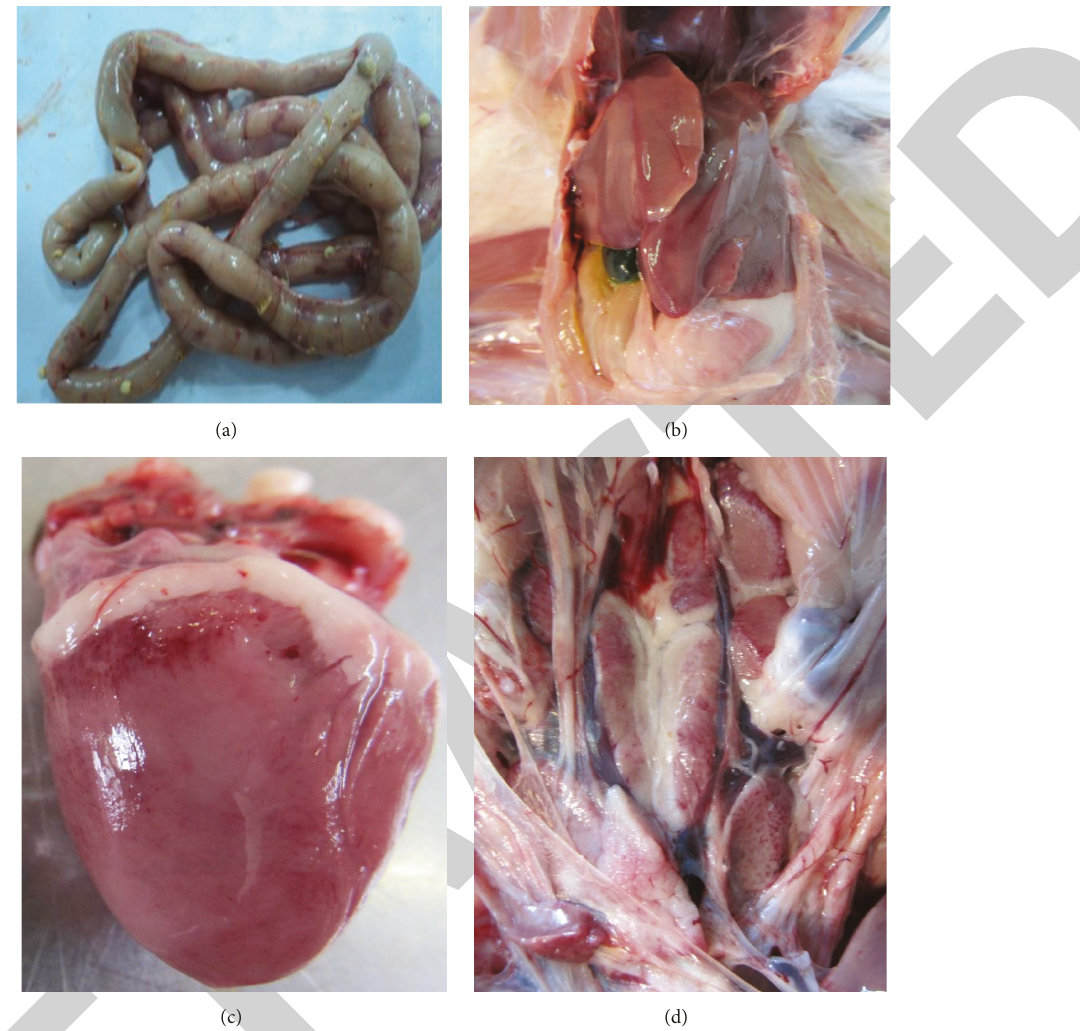
Figure 1: Turkeys of group D ( C. perfringens 10 8 CFU/turkey plus wheat based diet) show lesions: (a) haemorrhages and necrotic spots on intestine, (b) haemorrhagic liver, (c) haemorrhages on the epicardium of heart, and (d) haemorrhages on kidney.